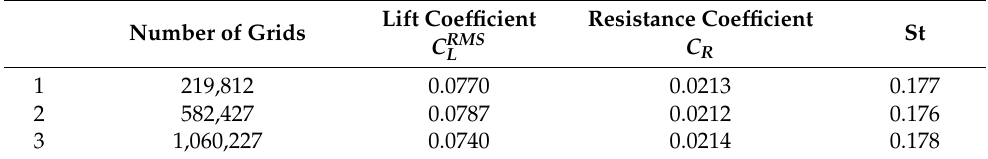
Table 2. Comparison of simulation results on the number of grids (time step: 0.001 s). Number of Grids